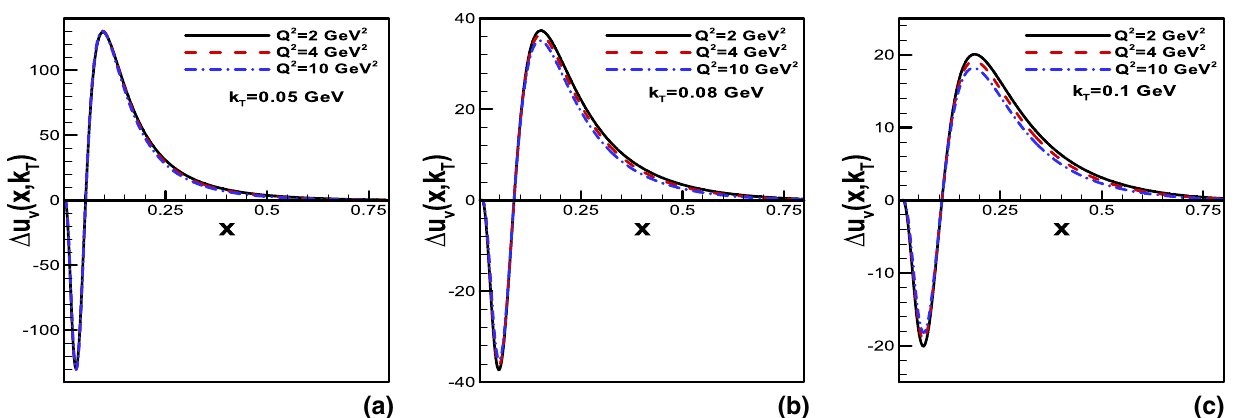
Fig. 11 The x -distribution of polarized up valence quark at a k T = 0 . 05 GeV, b k T = 0 . 08 GeV and c k T = 0 . 1 GeV. The TMD polarized valence distributions are plotted at three values of Q 2